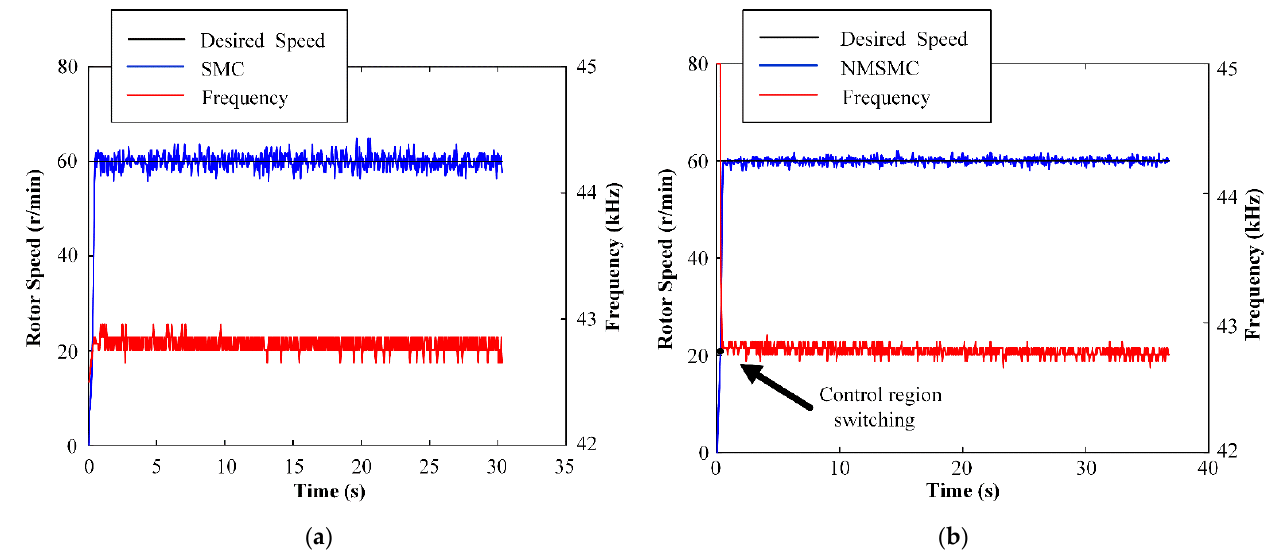
and the NMSMC are shown in Figure 11 when the desired speed changes from 60 to 70 to T = 0 N·m. Both controllers can respond to the desired speed quickly. An- 80 r/min and L alyzing in detail, the speed error range of the SMC is from 4.40 r/min to 5.20 r/min, and the speed error range of the NMSMC is from − 1.76 r/min to 1.84 r/min. Overall, the speed con-trolled by the NMSMC is smoother than that of the SMC.